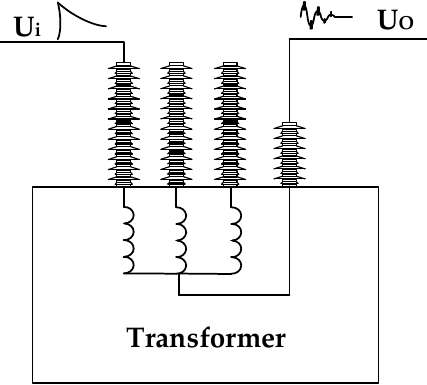
Figure 1. Detection principal diagram.